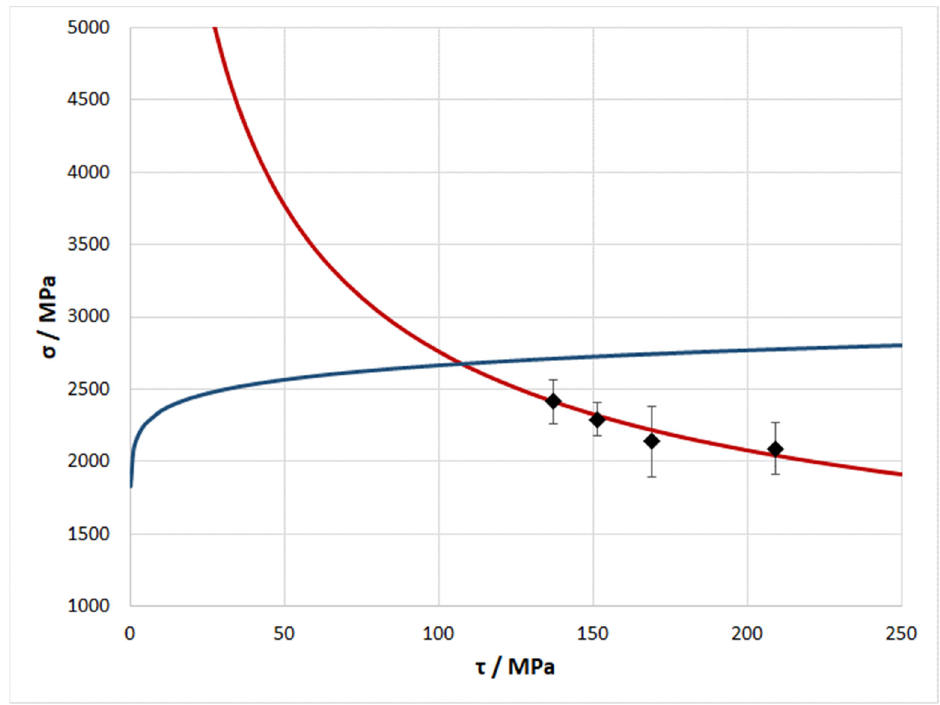
Figure 13. Plots of the dependencies of the strength of the composite calculated according to the refined mixture rule (blue curve) and the critical stress of crack propagation in the composite (red curve). Experimental composite strength values are marked with black dots.